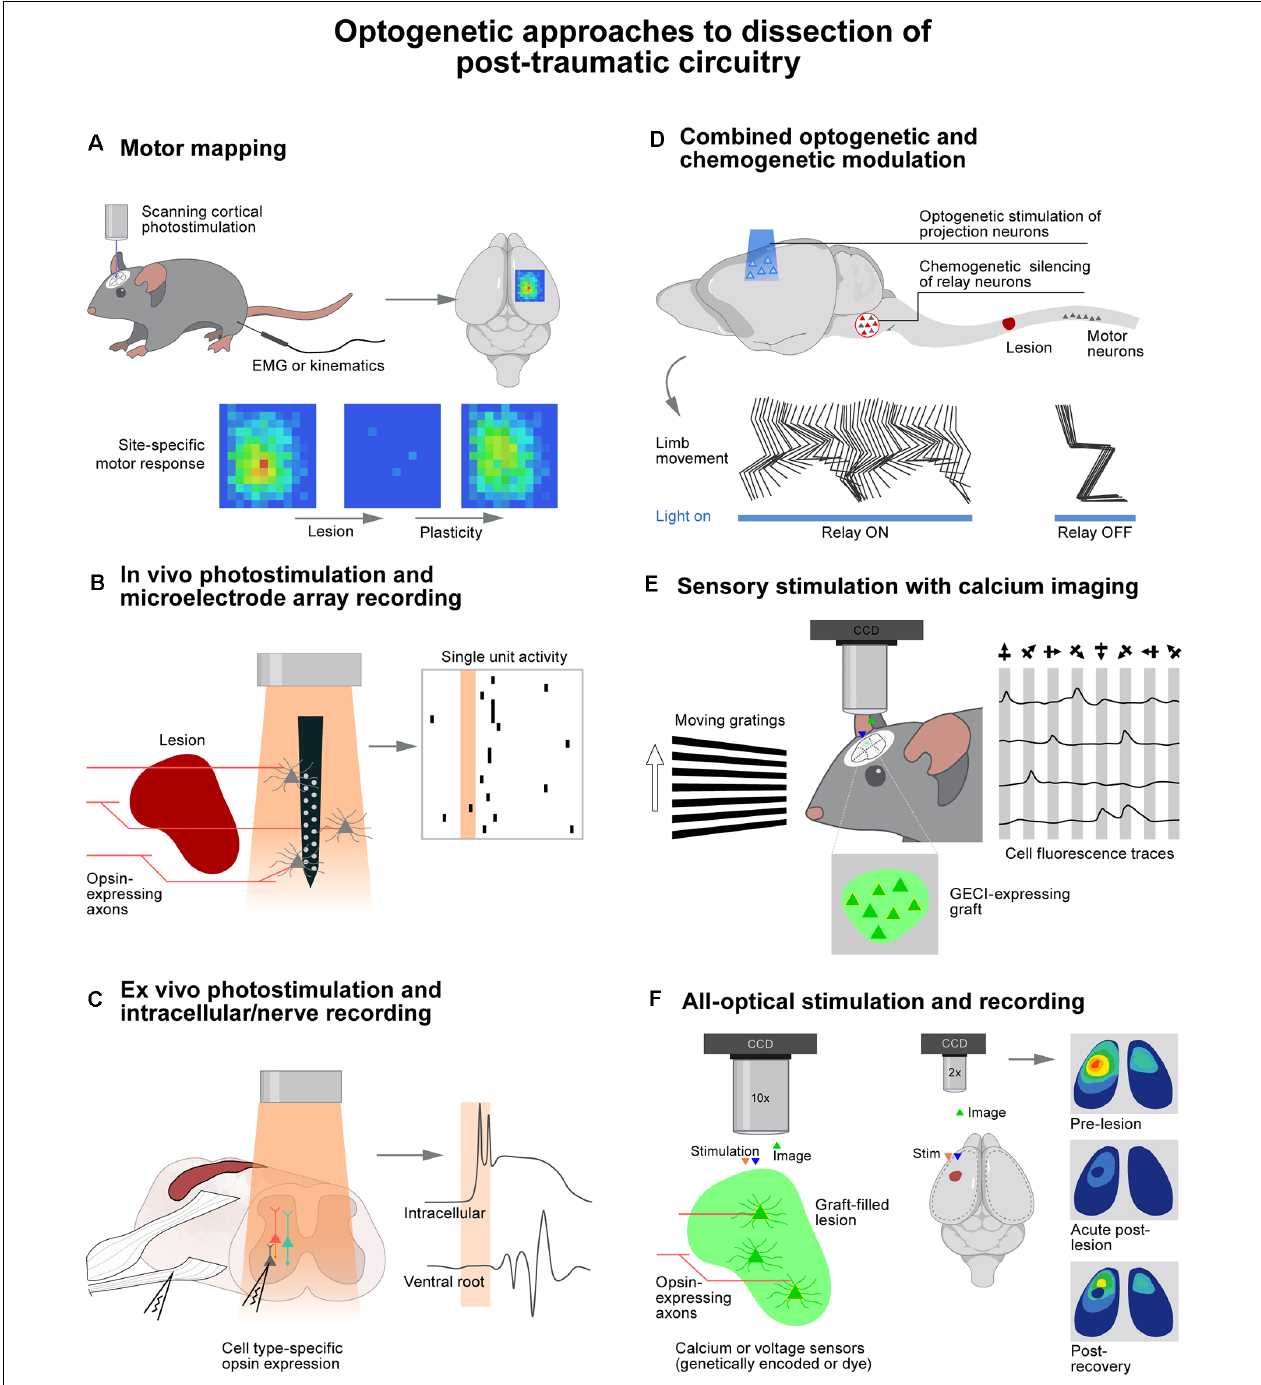
FIGURE 1 | Optogenetic approaches to dissection of post-traumatic circuitry. (A) Photostimulation of the cortex over a grid of sites while recording muscle responses or limb movements reveals motor plasticity following trauma to the brain or spinal cord. (B) Microelectrode arrays do minimal damage to perilesional tissue, allowing recording of responses to noninvasive photostimulation of sprouted or regenerated axons. (C) Ex vivo preparations enable precise control of drug and ion concentrations with clear access to obtain intracellular recordings. (D) Temporally precise optogenetic stimulation combined with noninvasive chemogenetic silencing of neuronal populations is a powerful approach to dissecting circuits critical for functional recovery after injury. (E) The activity of genetically defined neuronal populations such as cell grafts can be monitored during sensory stimulation (or motor behavior) to assess functional circuit integration. (F) All optical approaches allow simultaneous genetically defined stimulation and recording of large numbers of cells. Wavelengths of light used for stimulation and recording must be well separated.